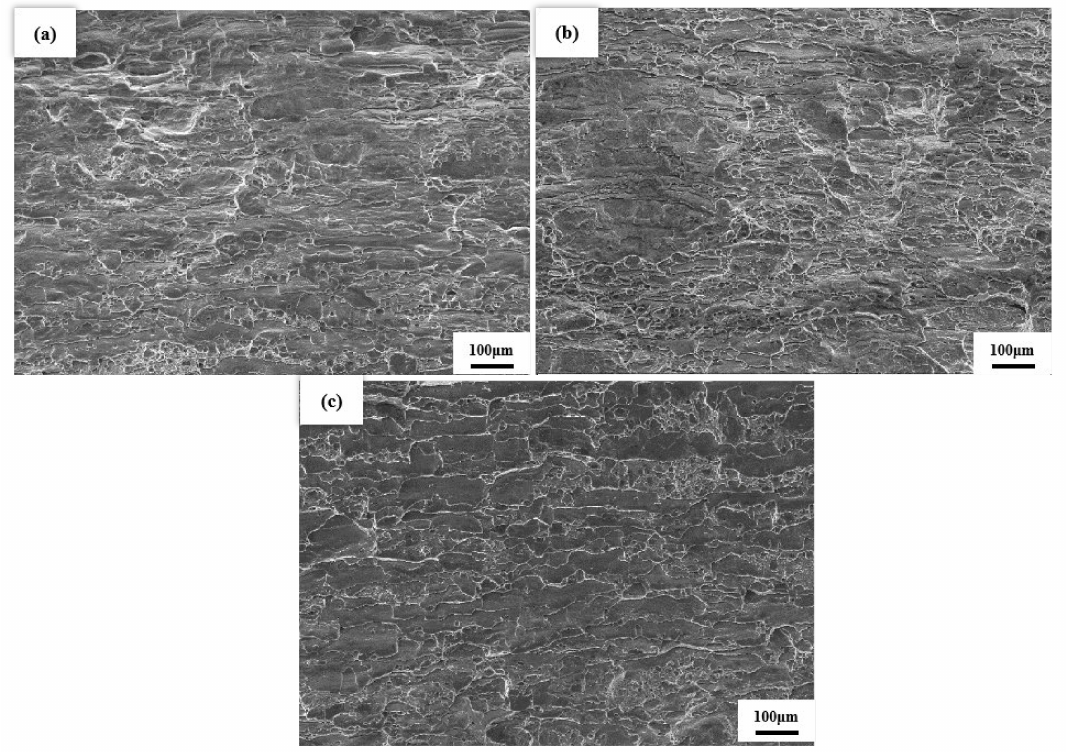
Figure 10. Fracture surface of robotic FSW of 2198 Al–Li alloys: ( a )welding speed of 50 mm/min; ( b ) welding speed of 200 mm/min; ( c ) welding speed of 500